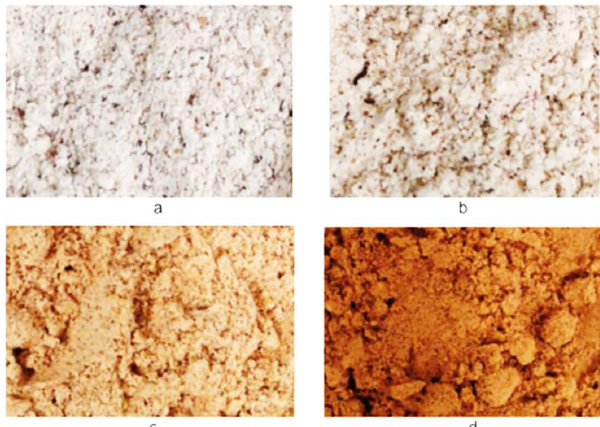
Figure 1. Bambara groundnut speciality malts: ( a ) base malt, ( b ) caramel malt, ( c ) roasted malt, and ( d ) toasted malt.